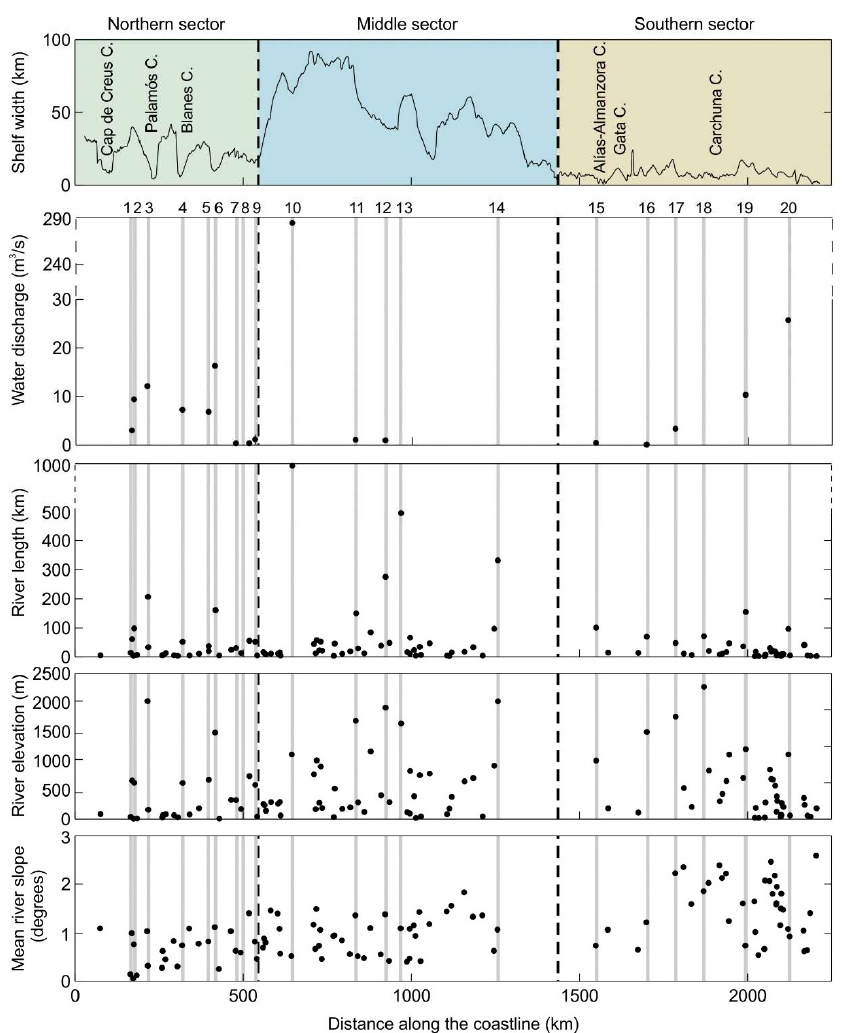
Figure 13. Along-margin variations of the shelf width and the main hydrologic (water discharge) and morphologic (river length, maximum elevation, and mean river slope) characteristics of the study rivers, as well as of the ephemeral streams identified along the margin. See Figure 3 for location. The middle sector continental shelves are fed by the Ebro River and other medium rivers such as the Mijares, Turia, Júcar and Segura (Figure 3). The Ebro River is the largest river of the Mediterranean margin in terms of length (969 km) and drainage area (84,608 km 2 ) (Figure 13, Table 3). Mean water discharge recorded in Tortosa, located 40 km upstream of the river mouth, for the period 1988–2018 is 238 m 3 s −1 , with peaks up to 2490 m 3 s −1 (Table 4). Historical analysis of river flooding revealed several major floods since 1780 (e.g., 1787, 1863, 1871, 1866, 1887, 1907) [54], with